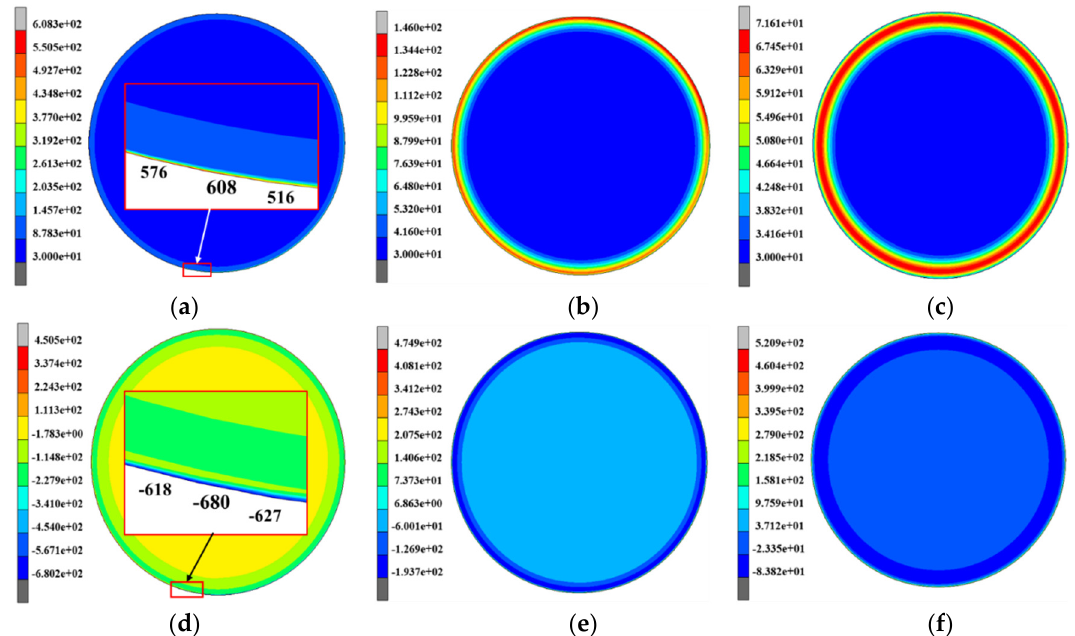
Figure 4. The contours of temperature monitored at the different time points: ( a ) t 1 = 61.06 s (after 30 revolutions of rolling), ( b ) t 2 = 76.03 s (start of idling) and ( c ) t 3 = 105.40 s (end of idling); the contours of thermal stress σ θ monitored at the different time points: ( d ) t 1 = 61.06 s (after 30 revolutions of rolling), ( e ) t 2 = 76.03 s (start of idling) and ( f ) t 3 = 105.40 s (end of idling).